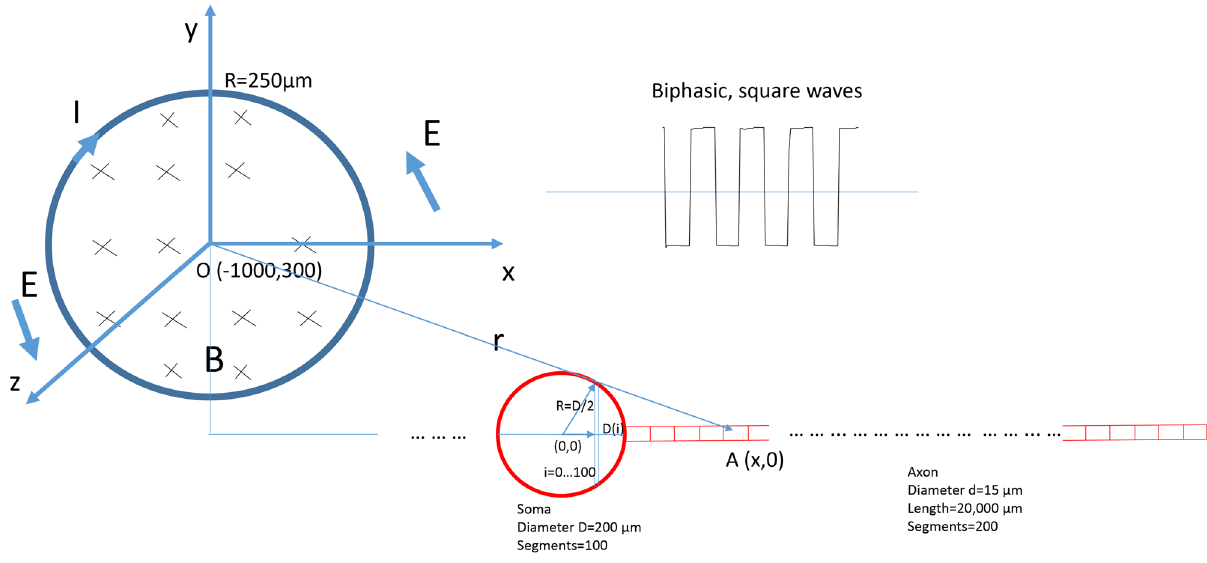
Figure 9. NEURON model for an Aplysia buccal neuron under miniature coil stimulation. The modeled neuron contained a spherical soma and a cylindrical axon. The soma sphere was 200 μm in diameter and was divided into 100 segments. The axon cylinder was 15 μm in diameter and 20,000 μm in length and was divided into 200 segments of equal length. Each neural compartment was modeled by H/H type ion channel mechanisms. The center of the soma was set to be (0, 0). The neuron was stimulated by a circular coil, whose center was located at (− 1000 µm, 300 µm). The radius of the coil was 250 μm. High frequency, biphasic electric pulses were delivered into the coil to induce electric field (E). I: coil current. X: direction of the magnetic flux when the coil current was increasing in a clockwise direction. Point A (x, 0) was an arbitrary point on the neuron, whose distance to the center of the coil is r in Eq. (2). Geometric parameter Value Soma diameter 200 µm Number of soma segments